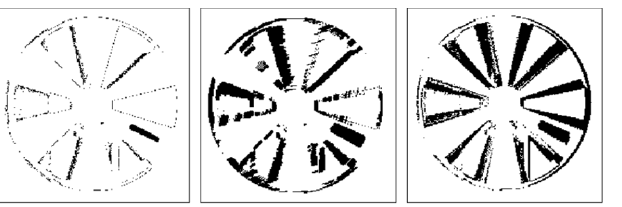
Figure 14. Combined radial ‐ linear motion from right to left without motion ( left ), with synthetic motion blur ( middle ), and with real linear motion blur ( right ).